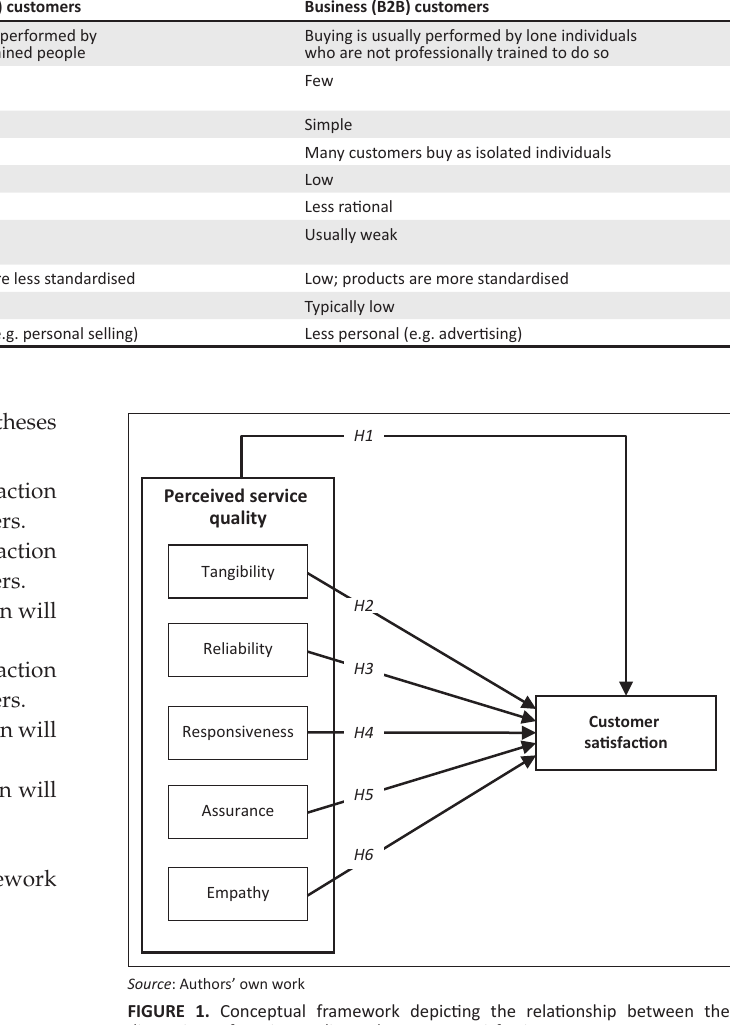
TABLE 1: Main differences between residential (B2C) and business (B2B) customers. Characteristic